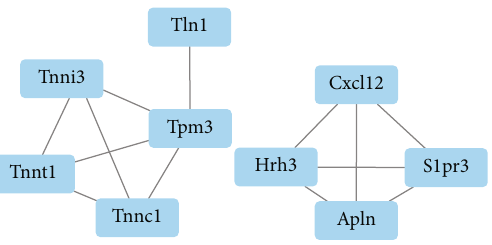
Figure 6: The hub genes were shown in the PPI